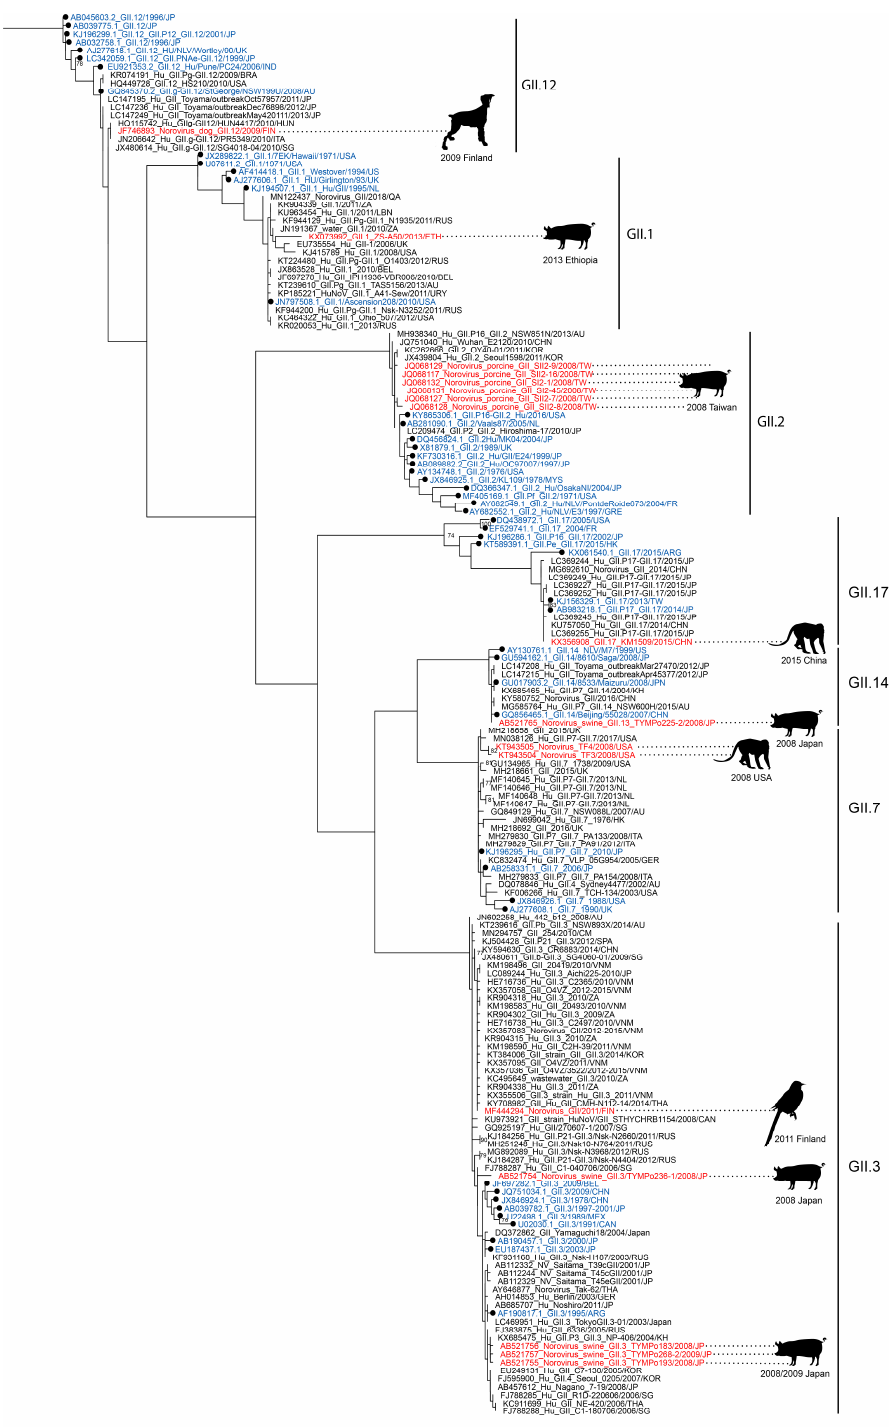
Figure 2. Genetic characterization of non-GII.4 GII sequences found in animals. A maximum-likelihood tree based on 180 bp GII sequences was inferred with PhyML v3.0 software using the general time reversible nucleotide substitution model (GTR + G). Sequences that were found in animals (red) were aligned with most closely related human sequences (black) and the reference sequences from the noronet typing tool (blue, black circle). The animal in which norovirus was found as well as the date and country of collection are indicated next to the sequence. The scale bar indicates nucleotide substitutions per